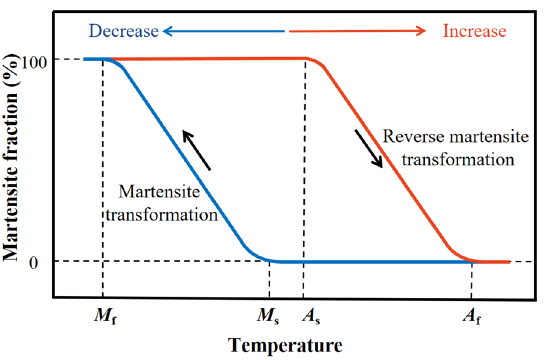
Figure 2. Schematic definition of characteristic temperatures in martensite transformation. Table 2. Martensite transformation temperatures of Fe-SMA.